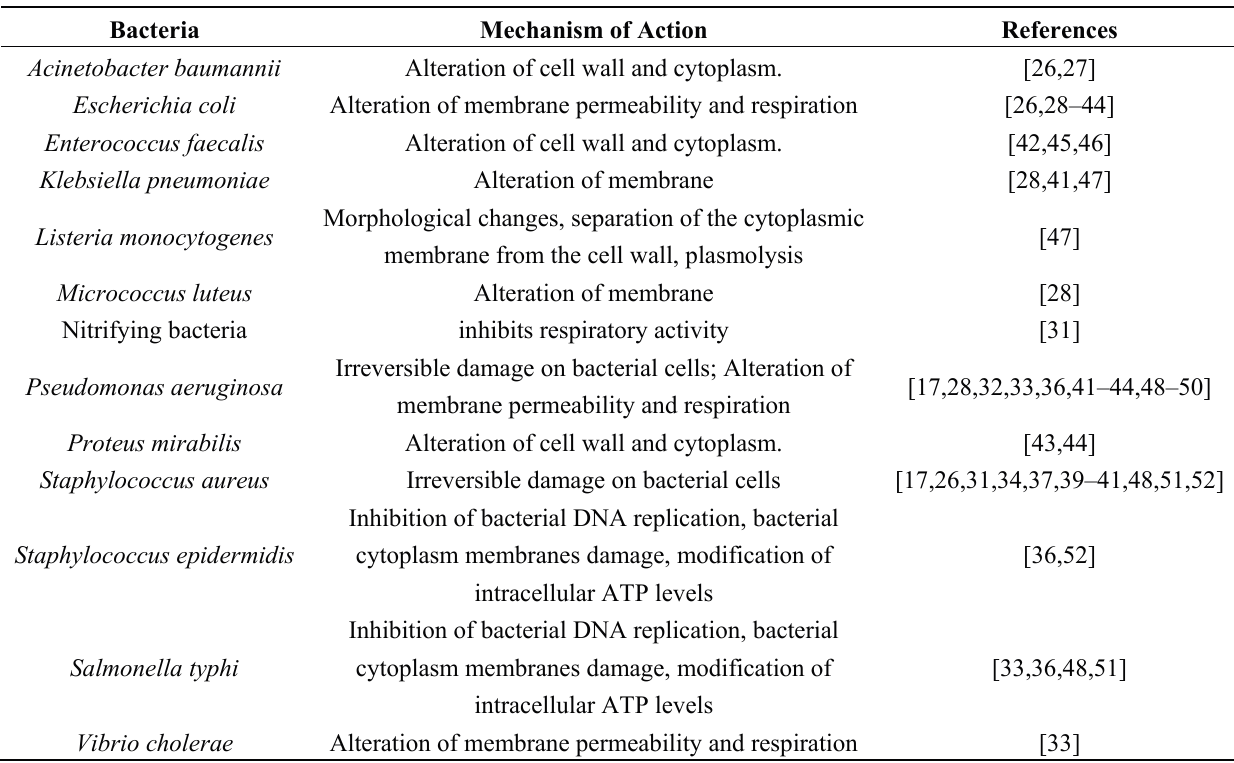
Table 1. Details of AgNPs and their mechanisms of action against bacteria and